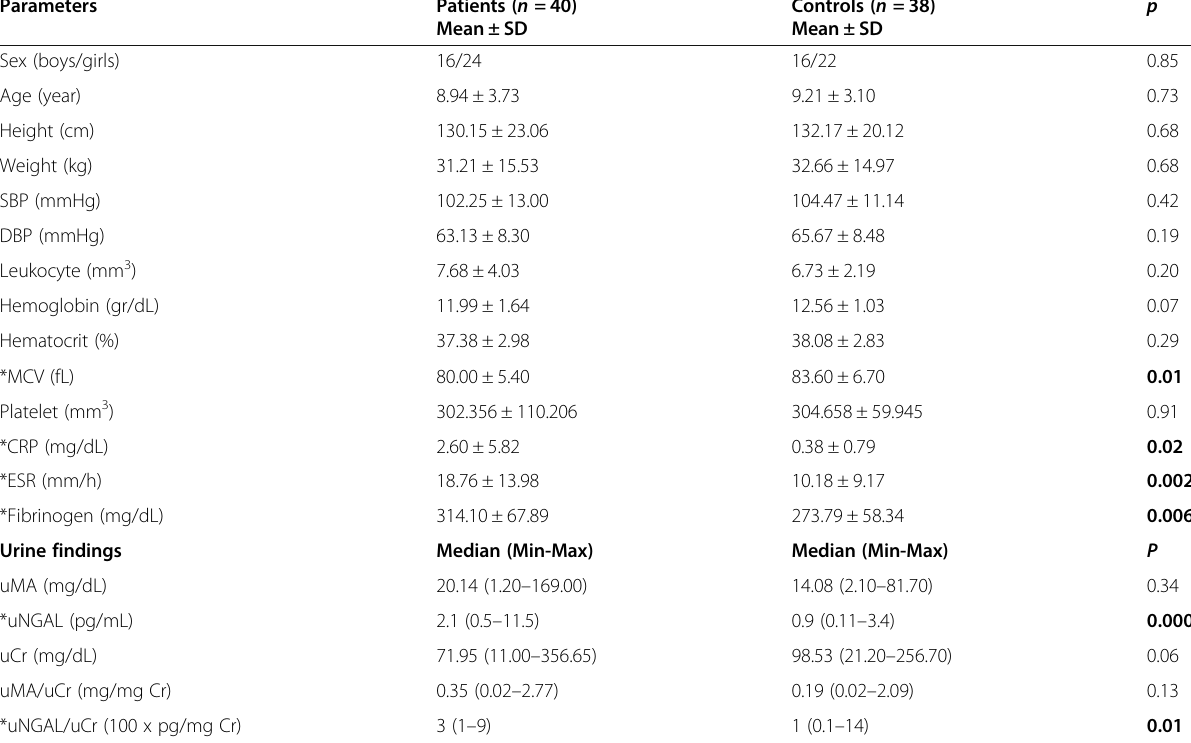
Table 1 Demographic data and laboratory findings in patients and controls